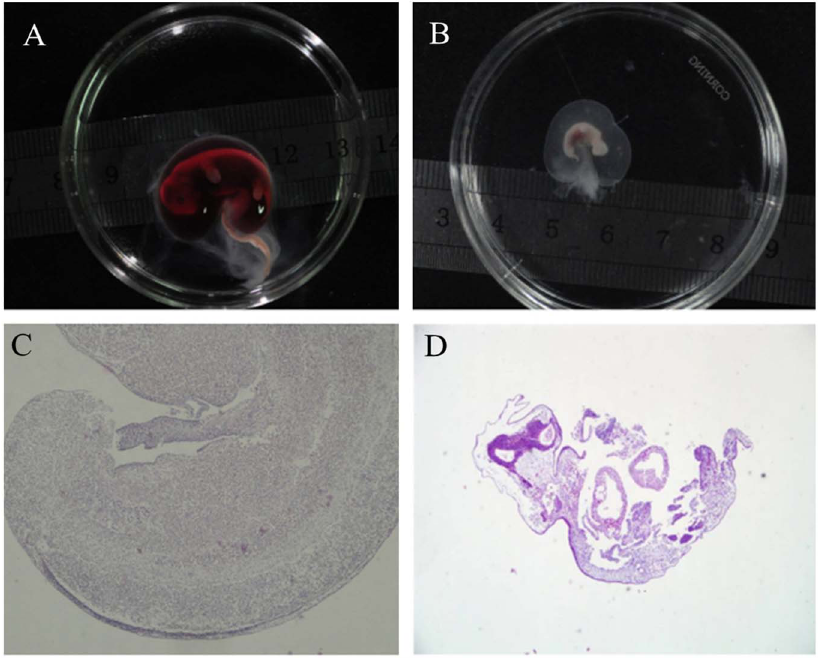
Figure 3. The PA fetus morphology and HE staining. (A) A large PA fetus with hemolysis. (B) A retarded ultra-small PA fetus. (C and D) HE staining of paraffin-embedded sections of large and ultra-small PA fetuses. The cell apoptosis is shown in the ultra-small fetus.